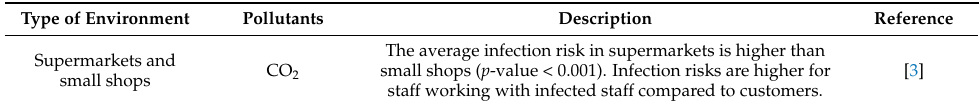
Table 1. Summary of previous studies monitoring PM 2.5 and/or CO 2 concentrations for assessing the air change rates, ventilation settings and infection transmission of